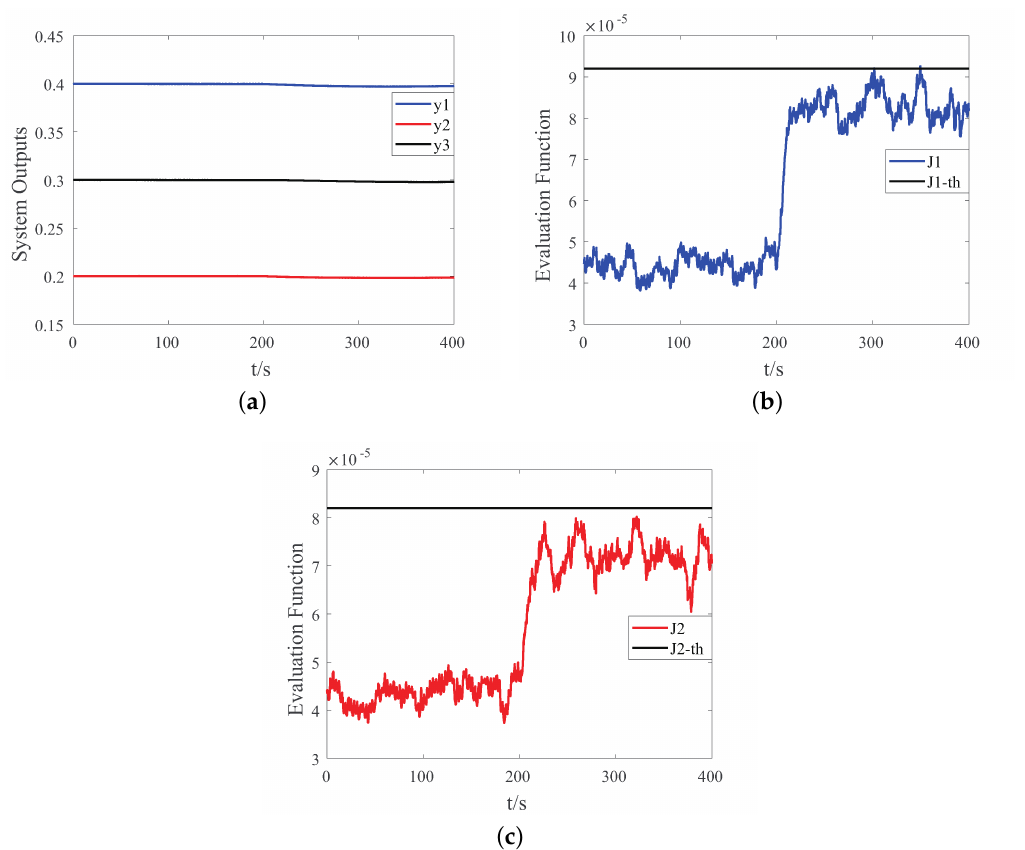
Figure 3. Simulation results of the system without faults and two auxiliary signals a [ 1 ] and a [ 2 ] are injected into the system at 200 s: ( a ) system outputs; ( b ) the evaluation function of the residual r [ 1 ] and the corresponding threshold; ( c ) the evaluation function of the residual r [ 2 ] and the corresponding